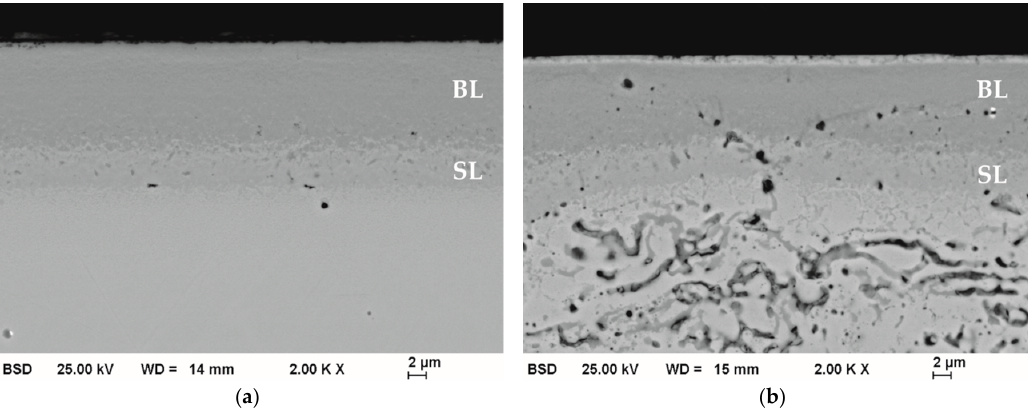
Figure 3. SEM images (BSD) of the borided surface layer comprising the B-rich layer (BL) and the second layer (SL): ( a ) cast CrFeCoNi; ( b ) HVOF coating CrFeCoNi.